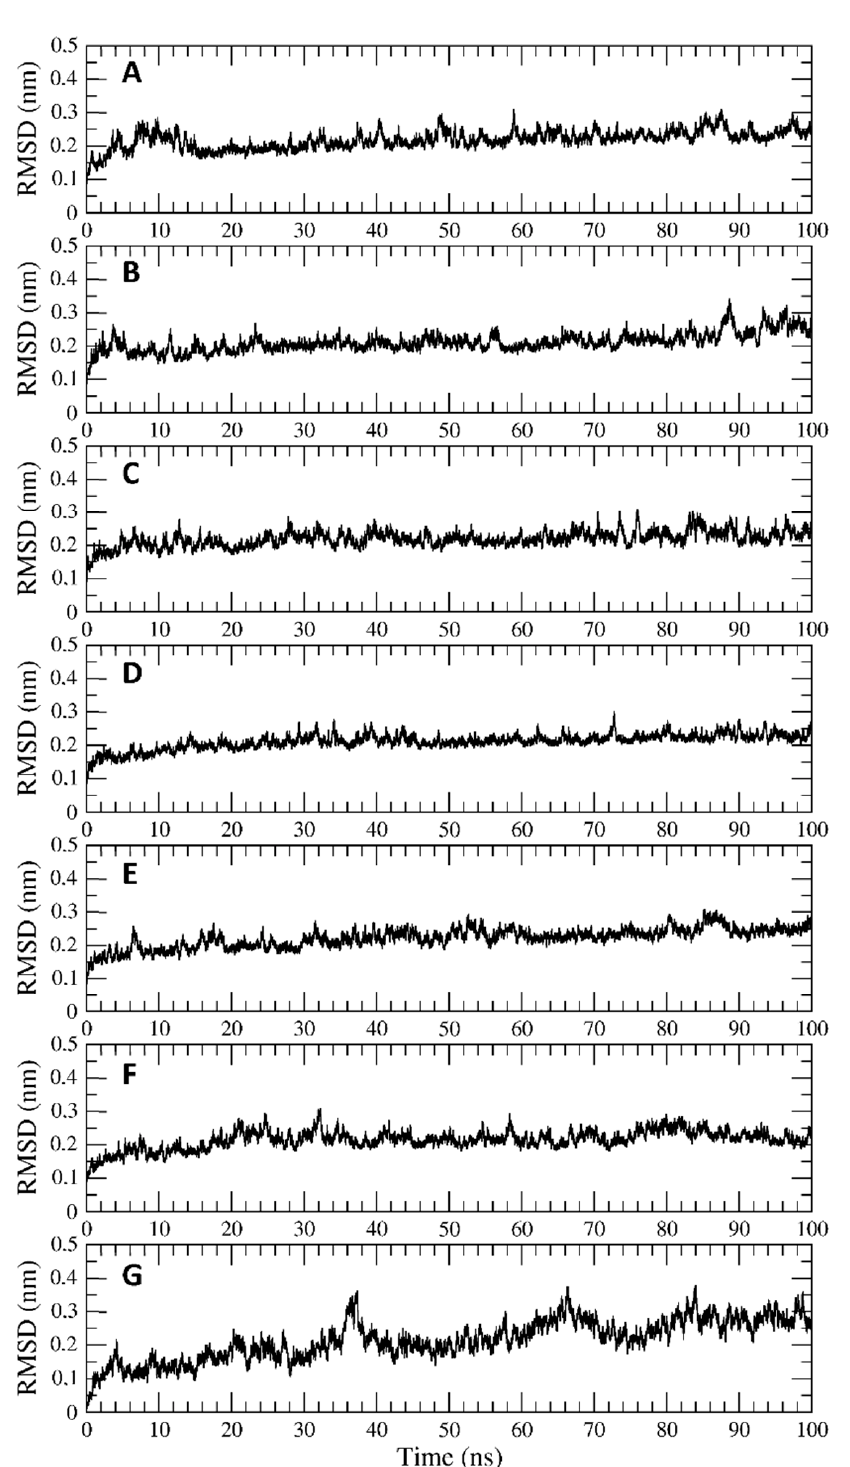
Figure 2. RMSD values as a function of simulation time for the complexes between bovine lactoferrin and ( A ) Epigallocatechin-3-gallate, ( B ) Taxifolin-3-glucoside, ( C ) Gallocatechin, ( D ) Artelin, ( E ) Pentagalloyl glucose, ( F ) Vitexin, ( G ) Isoorientin. Table 2. Results of MM-GBSA analysis of the bovine Lf- PEL compounds complexes. For each com- pound, we reported the average interaction energy calculated over the last 30 ns of the trajectory.